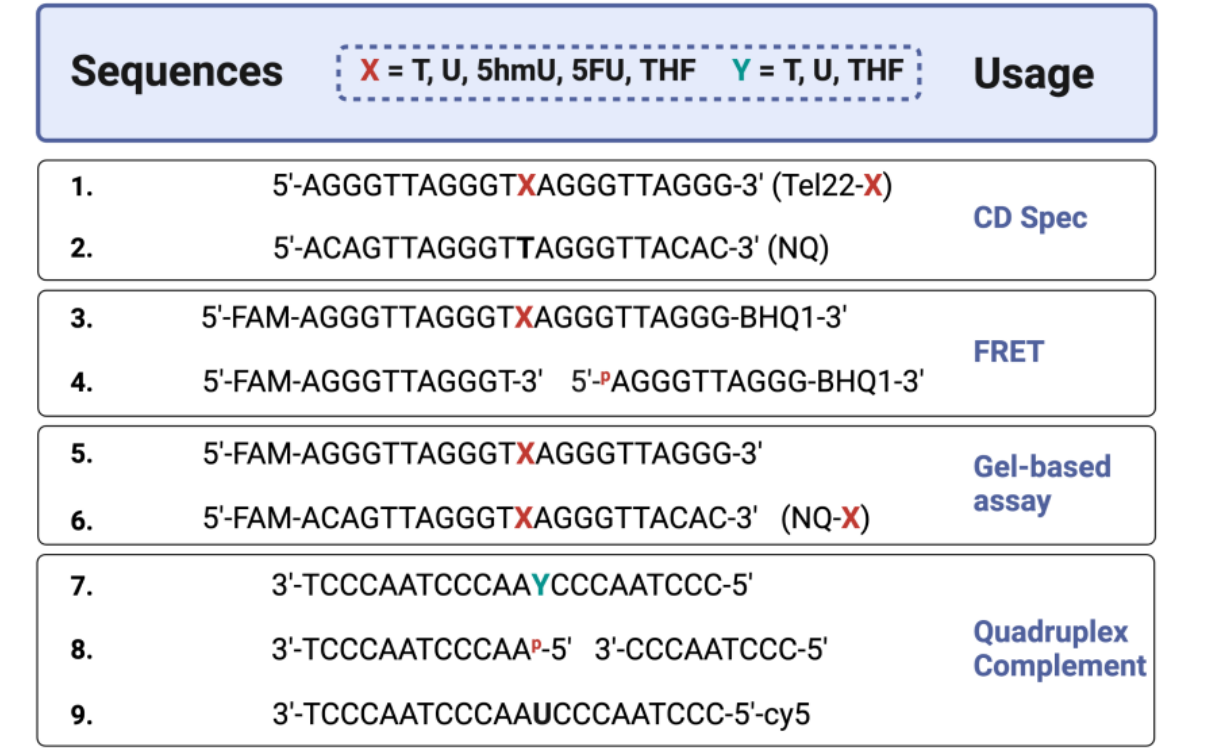
Figure 1. Sequences of oligonucleotides used in this study. Synthetic oligonucleotides of the telo-